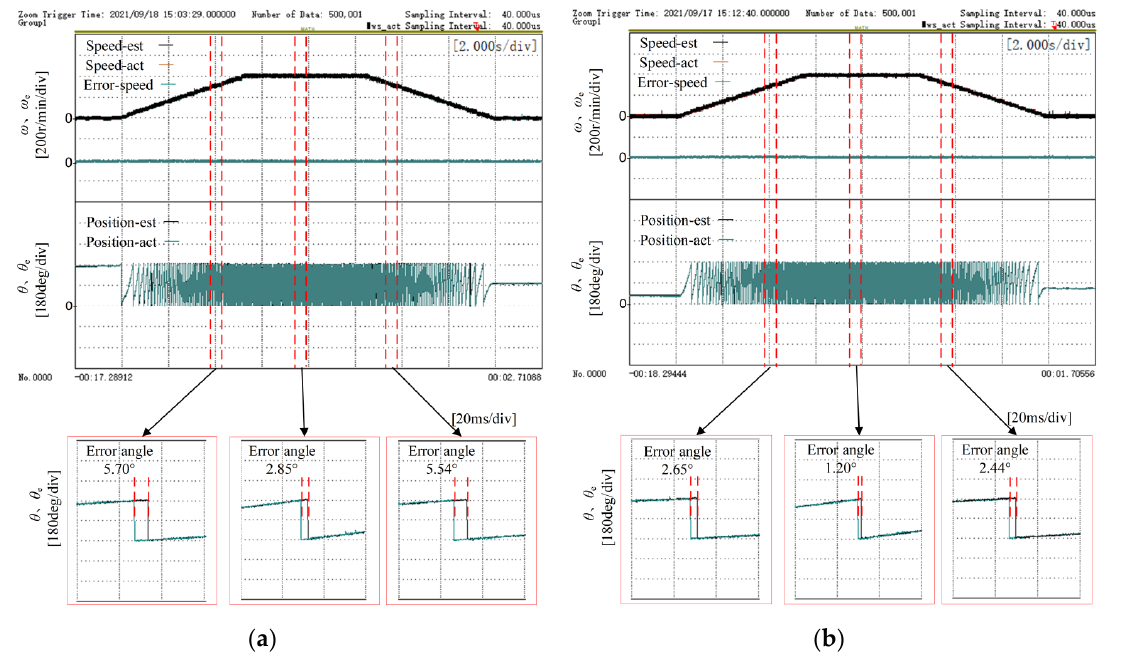
Figure 13. The speed control of dynamometer with traditional method and the proposed method from 0 r/min to 400 r/min, and from 400 r/min to 0 r/min: ( a ) traditional method; ( b ) the proposed method.